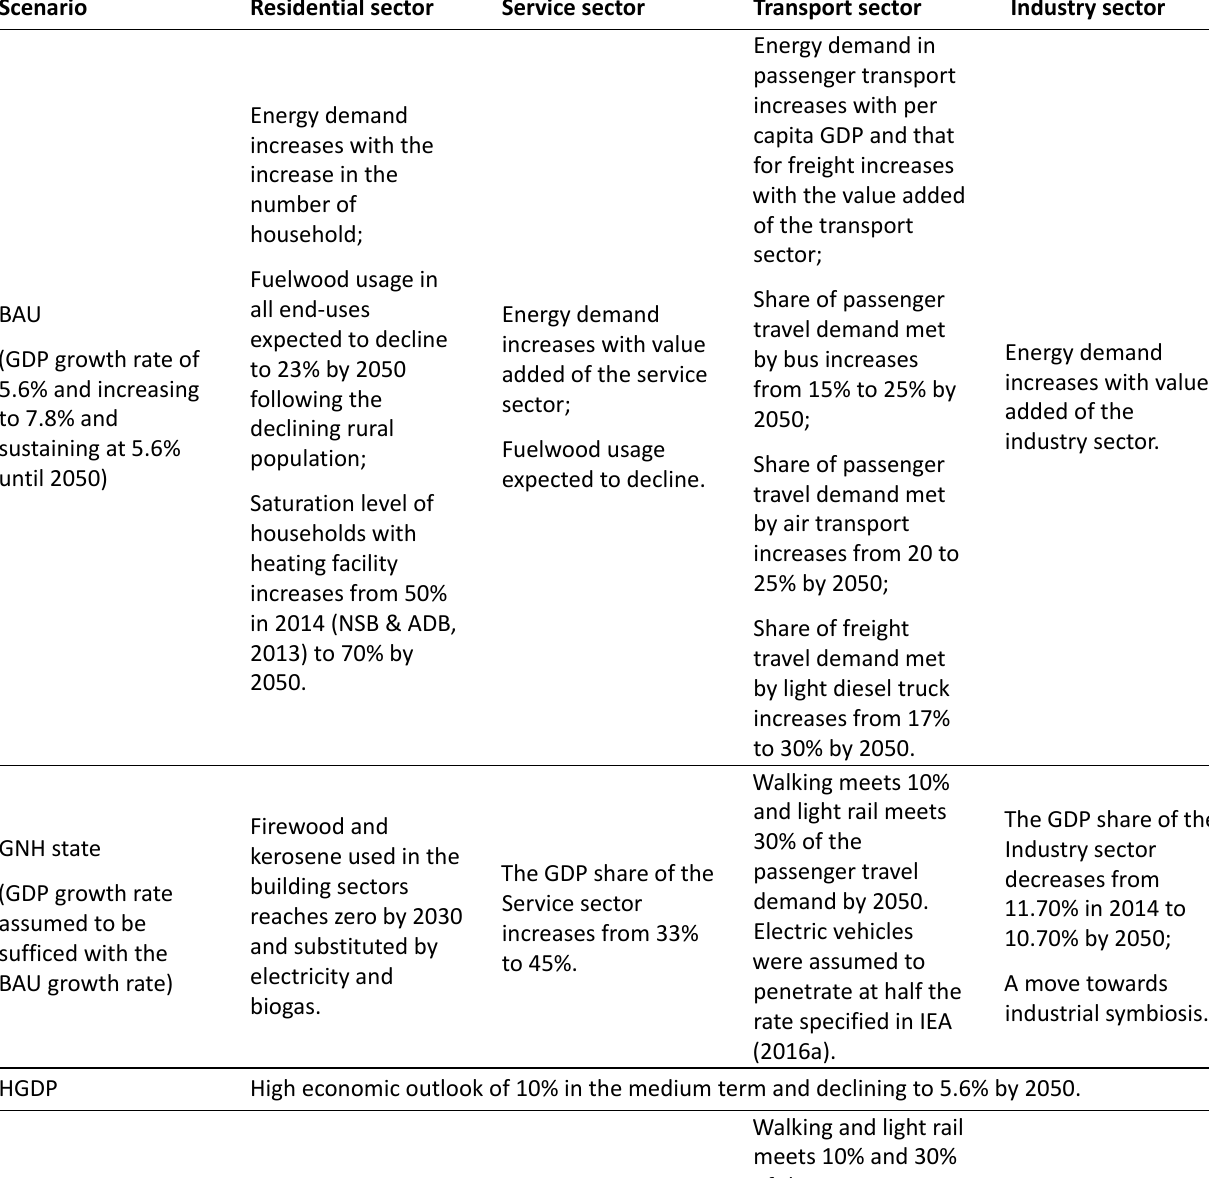
Table 1. Key features of the four